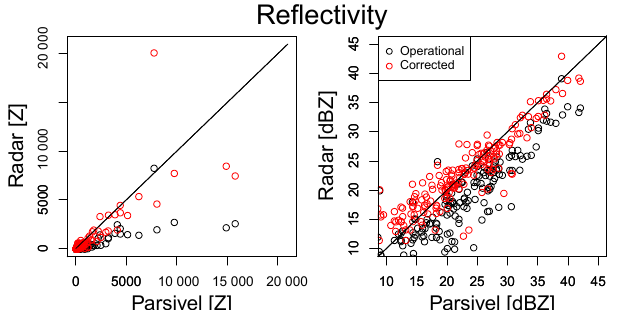
Figure 8. Left panel: reflectivity ( Z ) measured by the radar and derived from the Parsivel ® , where the black circles are the opera- tionally corrected values and the red circles the fully corrected data described in this paper. Right panel: same as left panel but on a logarithmic